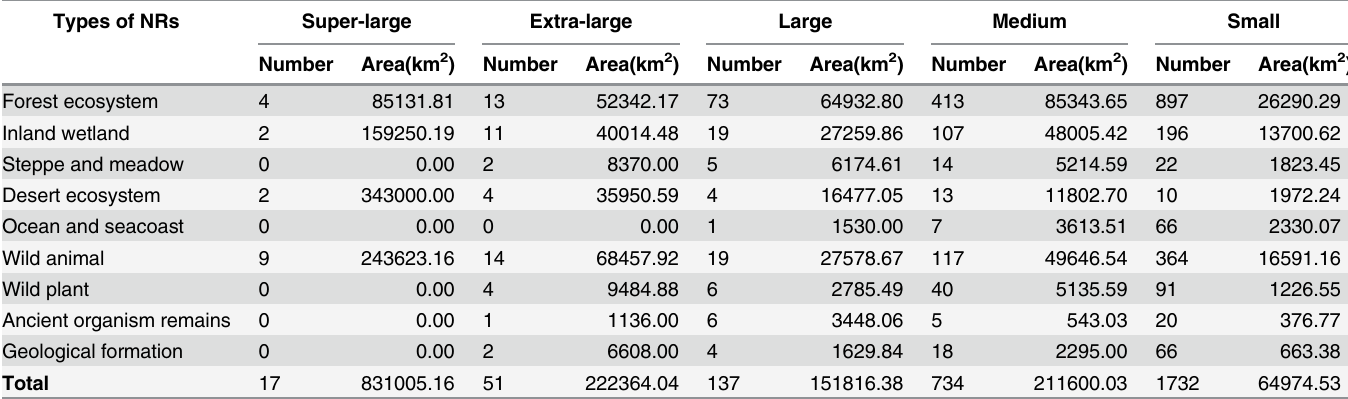
Table 4. Statistics for NR sizes in mainland China.